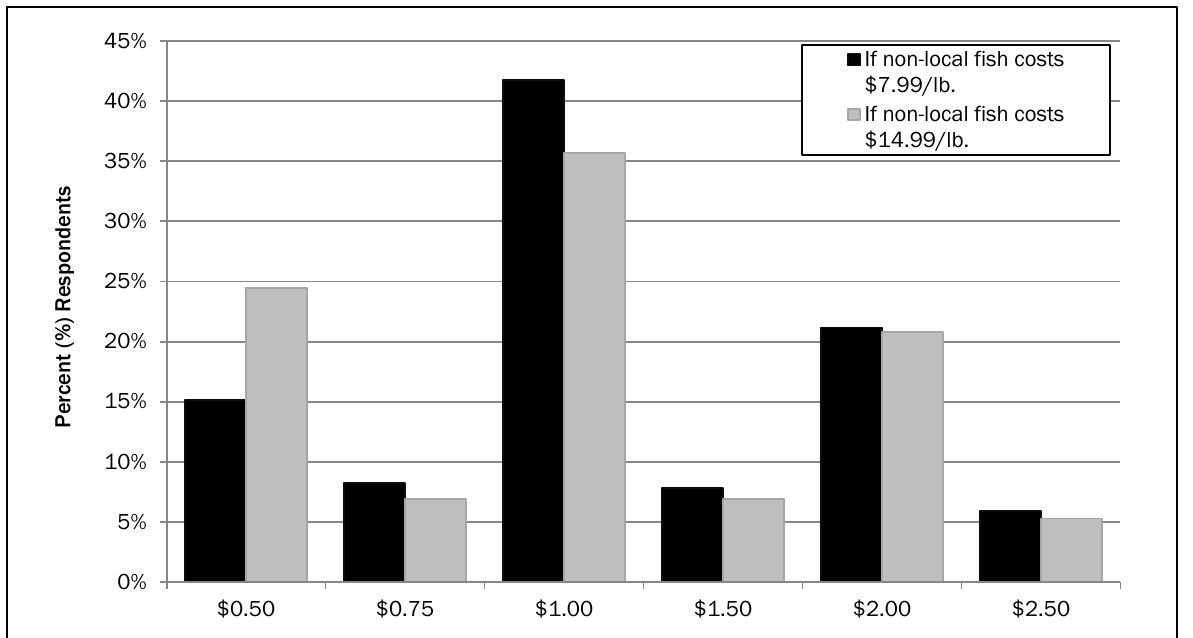
Figure 1. Respondent Willingness to Pay Additional Money for Local Fish of Similar Quality Over Non-local